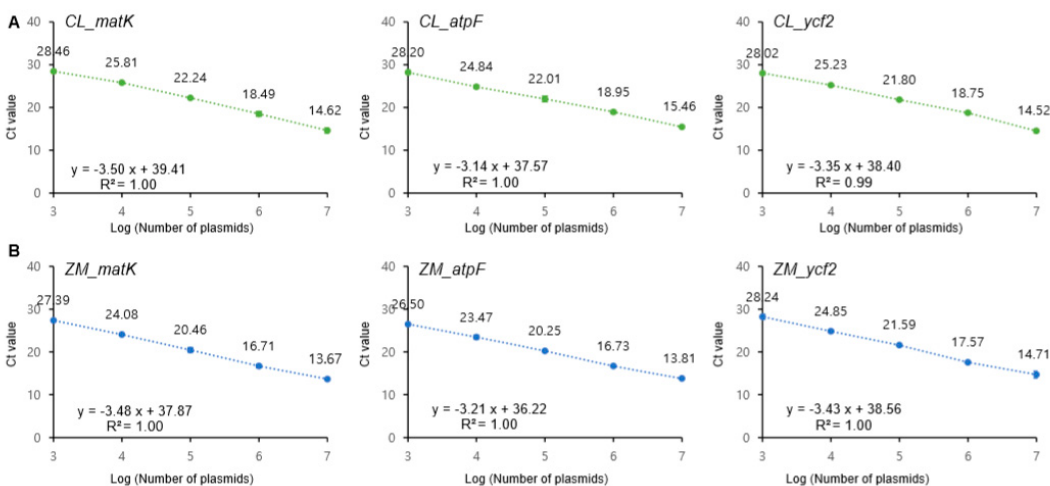
Figure 1. Standard curve of cycle threshold (Ct) values were obtained on the basis of efficiency and correlation of coefficient ( R 2 ) in serial dilution series recombinant plasmids (C. longa and Z. mays) using species-specific primer sets. The x-axis represents log number of plasmids and the y-axis represents means of Ct value ± SD. ( A ) C. longa targeting primer sets (CL_matK, CL_atpF, and CL_ycf2). Green dots represent serial dilution series of recombinant plasmids (107–103) containing C. longa specific target gene (matK, atpF and ycf2) sequences; ( B ) Z. mays targeting primer sets (ZM_matK, ZM_atpF, and ZM_ycf2). Blue dots represent serial dilution series of recombinant plasmids (107–103) containing Z. mays specific target gene (matK, atpF and ycf2) sequences. The real-time PCRs were carried out in triplicate ( n = 3).